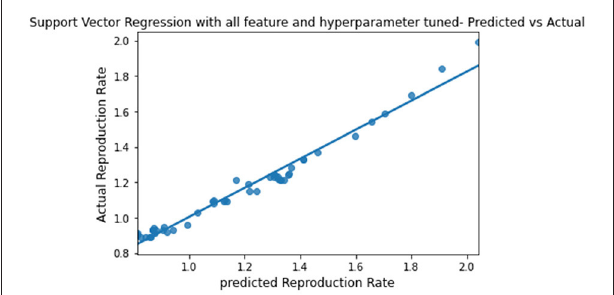
TABLE 7 | Running time of algorithms with hyperparameter tuning and prediction.